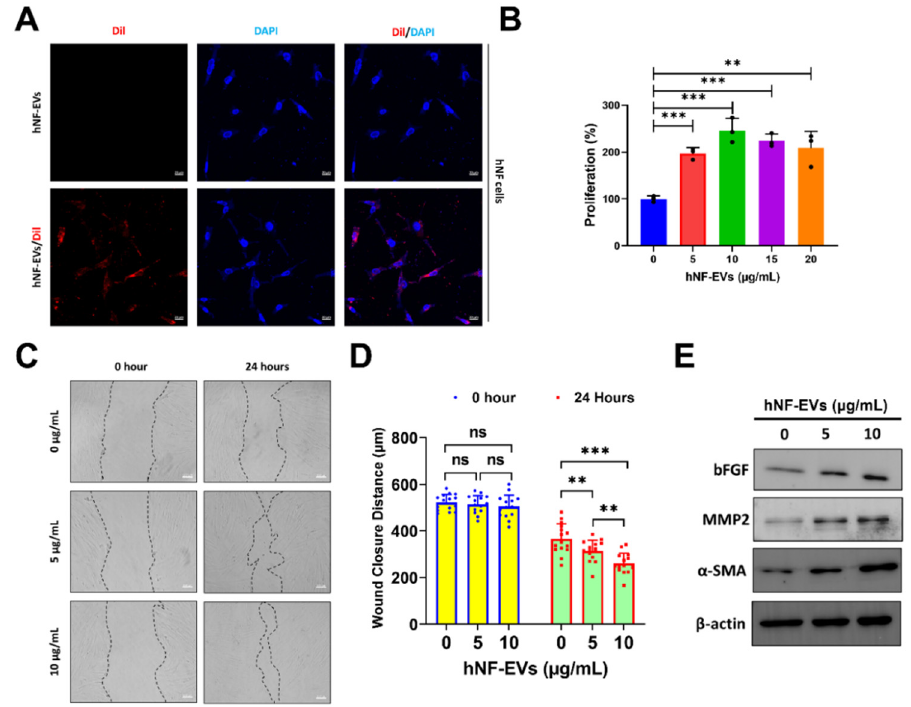
Figure 4. The treatment of hNF-EVs modulates hNF functions in vitro. ( A ) Fluorescent microscopy images of hNF cells treated with 10 µg/mL of hNF-EVs or hNF-EVs/DiI (scale bar: 20 µm). ( B ) The cellular proliferation of hNF cells treated with hNF-EVs (0, 5, 10, 15, and 20 µg/mL) for 24 h, quantified using a CCK8 assay kit ( n = 3). ( C ) Representative phase-contrast images of hNF cells at 0 and 24 h after treatment with hNF-EVs (5 and 10 µg/mL), scale bar: 100 µm. ( D ) Distance measurements of wounds (C) at 0 and 24 h ( n = 15). ( E ) WB analysis of hNF cells after 24 h of hNF-EVs treatments (5 and 10 µg/mL) probed with bFGF, MMP2, and α -SMA antibodies; β -actin was used as a loading control. ** p < 0.01; *** p < 0.001 and ns: not significant. A student’s t -test was used for